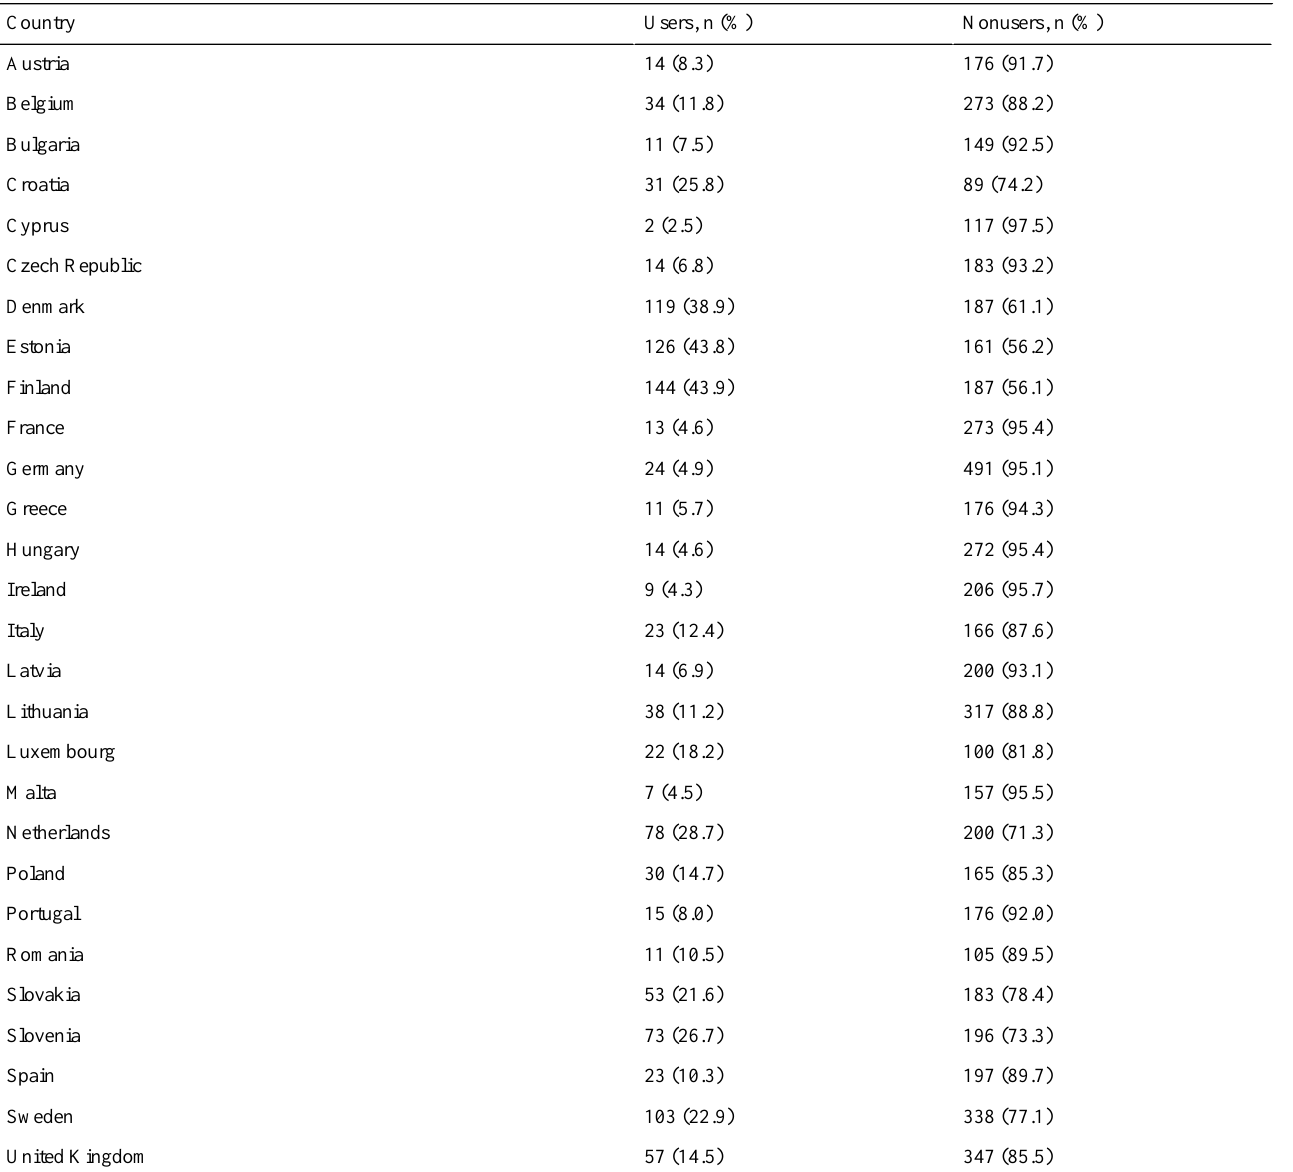
Table 1. Use of internet-based health care services among elderly people (aged 65 years or older,